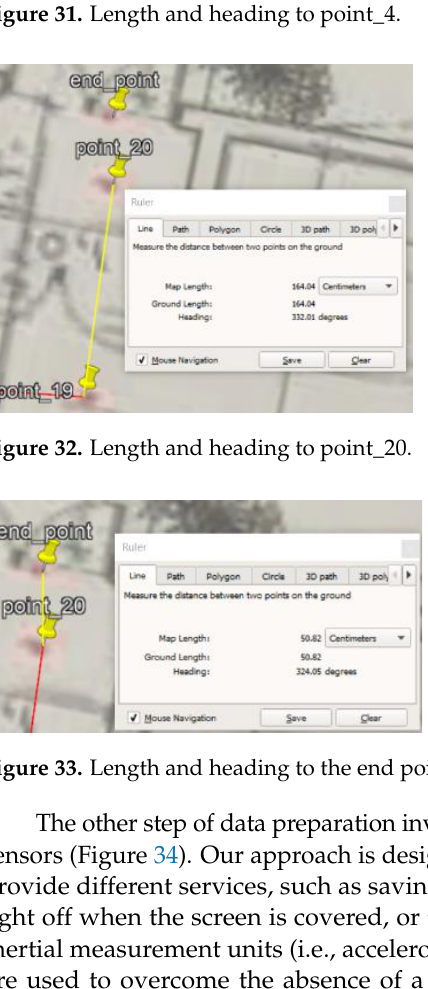
Figure 31. Length and heading to point_4.